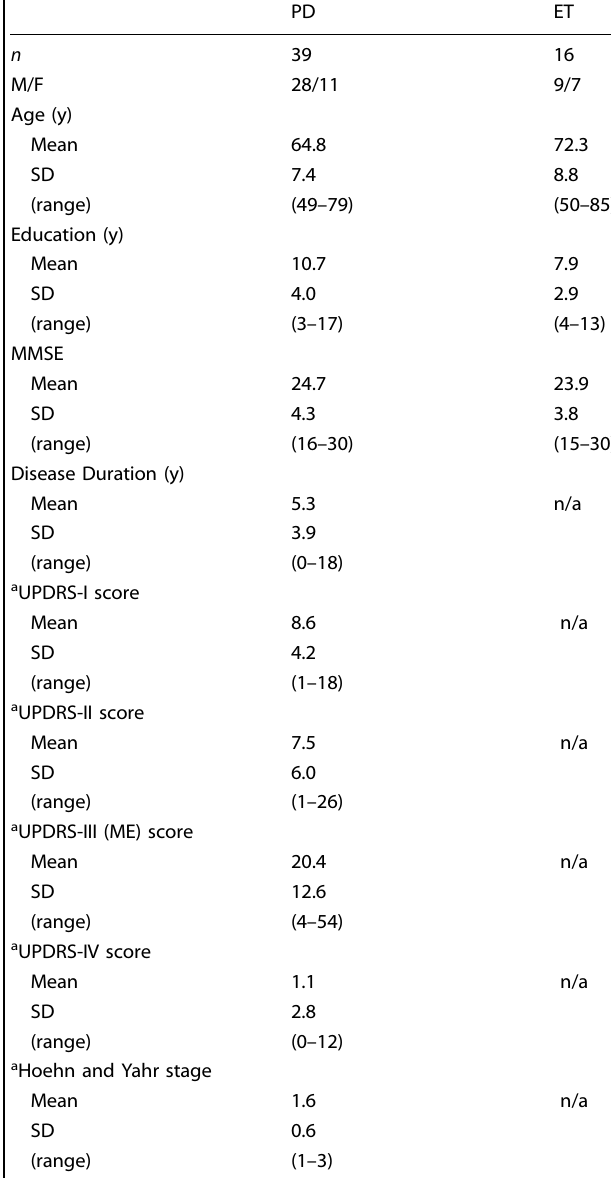
Table 1. Composition of PD and ET patient